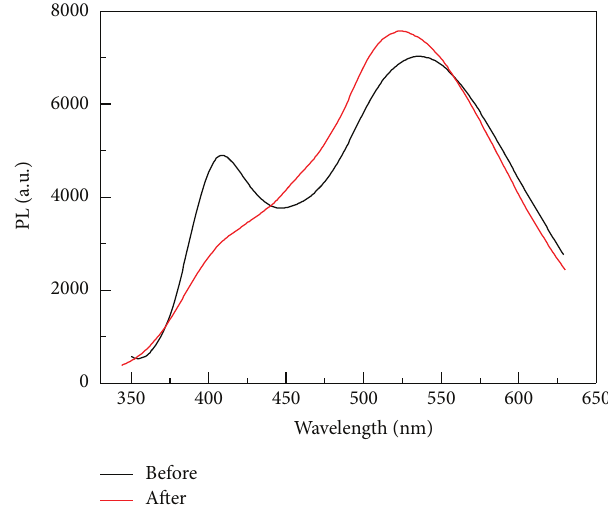
Figure 5: Room-temperaturespectra ofs5 beforeand after exposure to